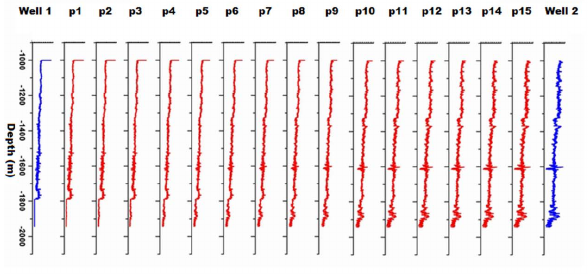
Fig. 5. Result of a fractal interpolation of neutron porosity well log data between two wells.